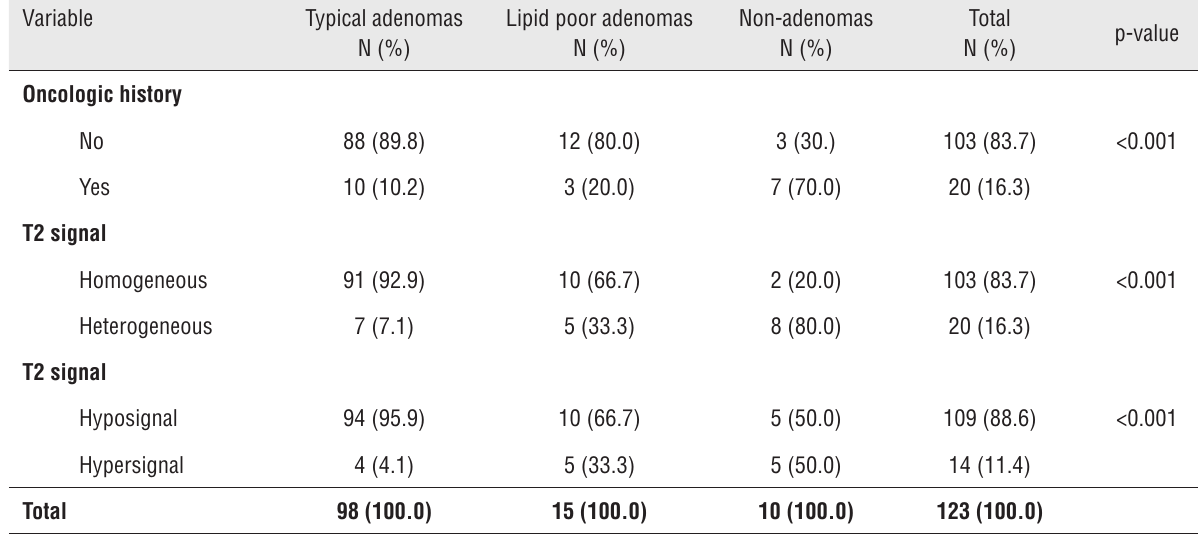
Lipid poor adenomas N (%)